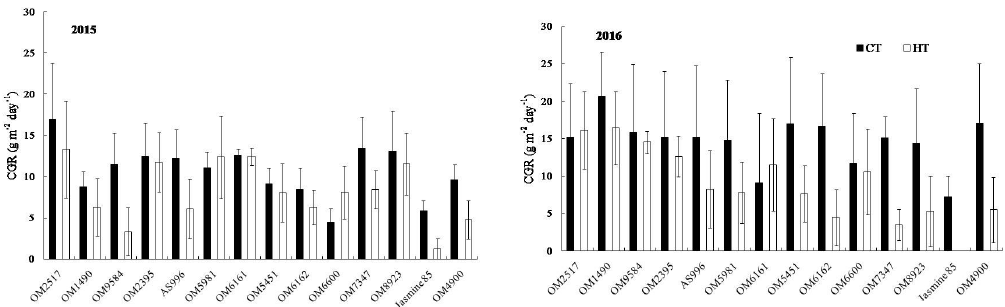
Figure 2. Effect of high temperature on the crop growth rate (CGR) during the ripening period in 2015 and 2016. Vertical bars indicate SD of means ( n = 4).